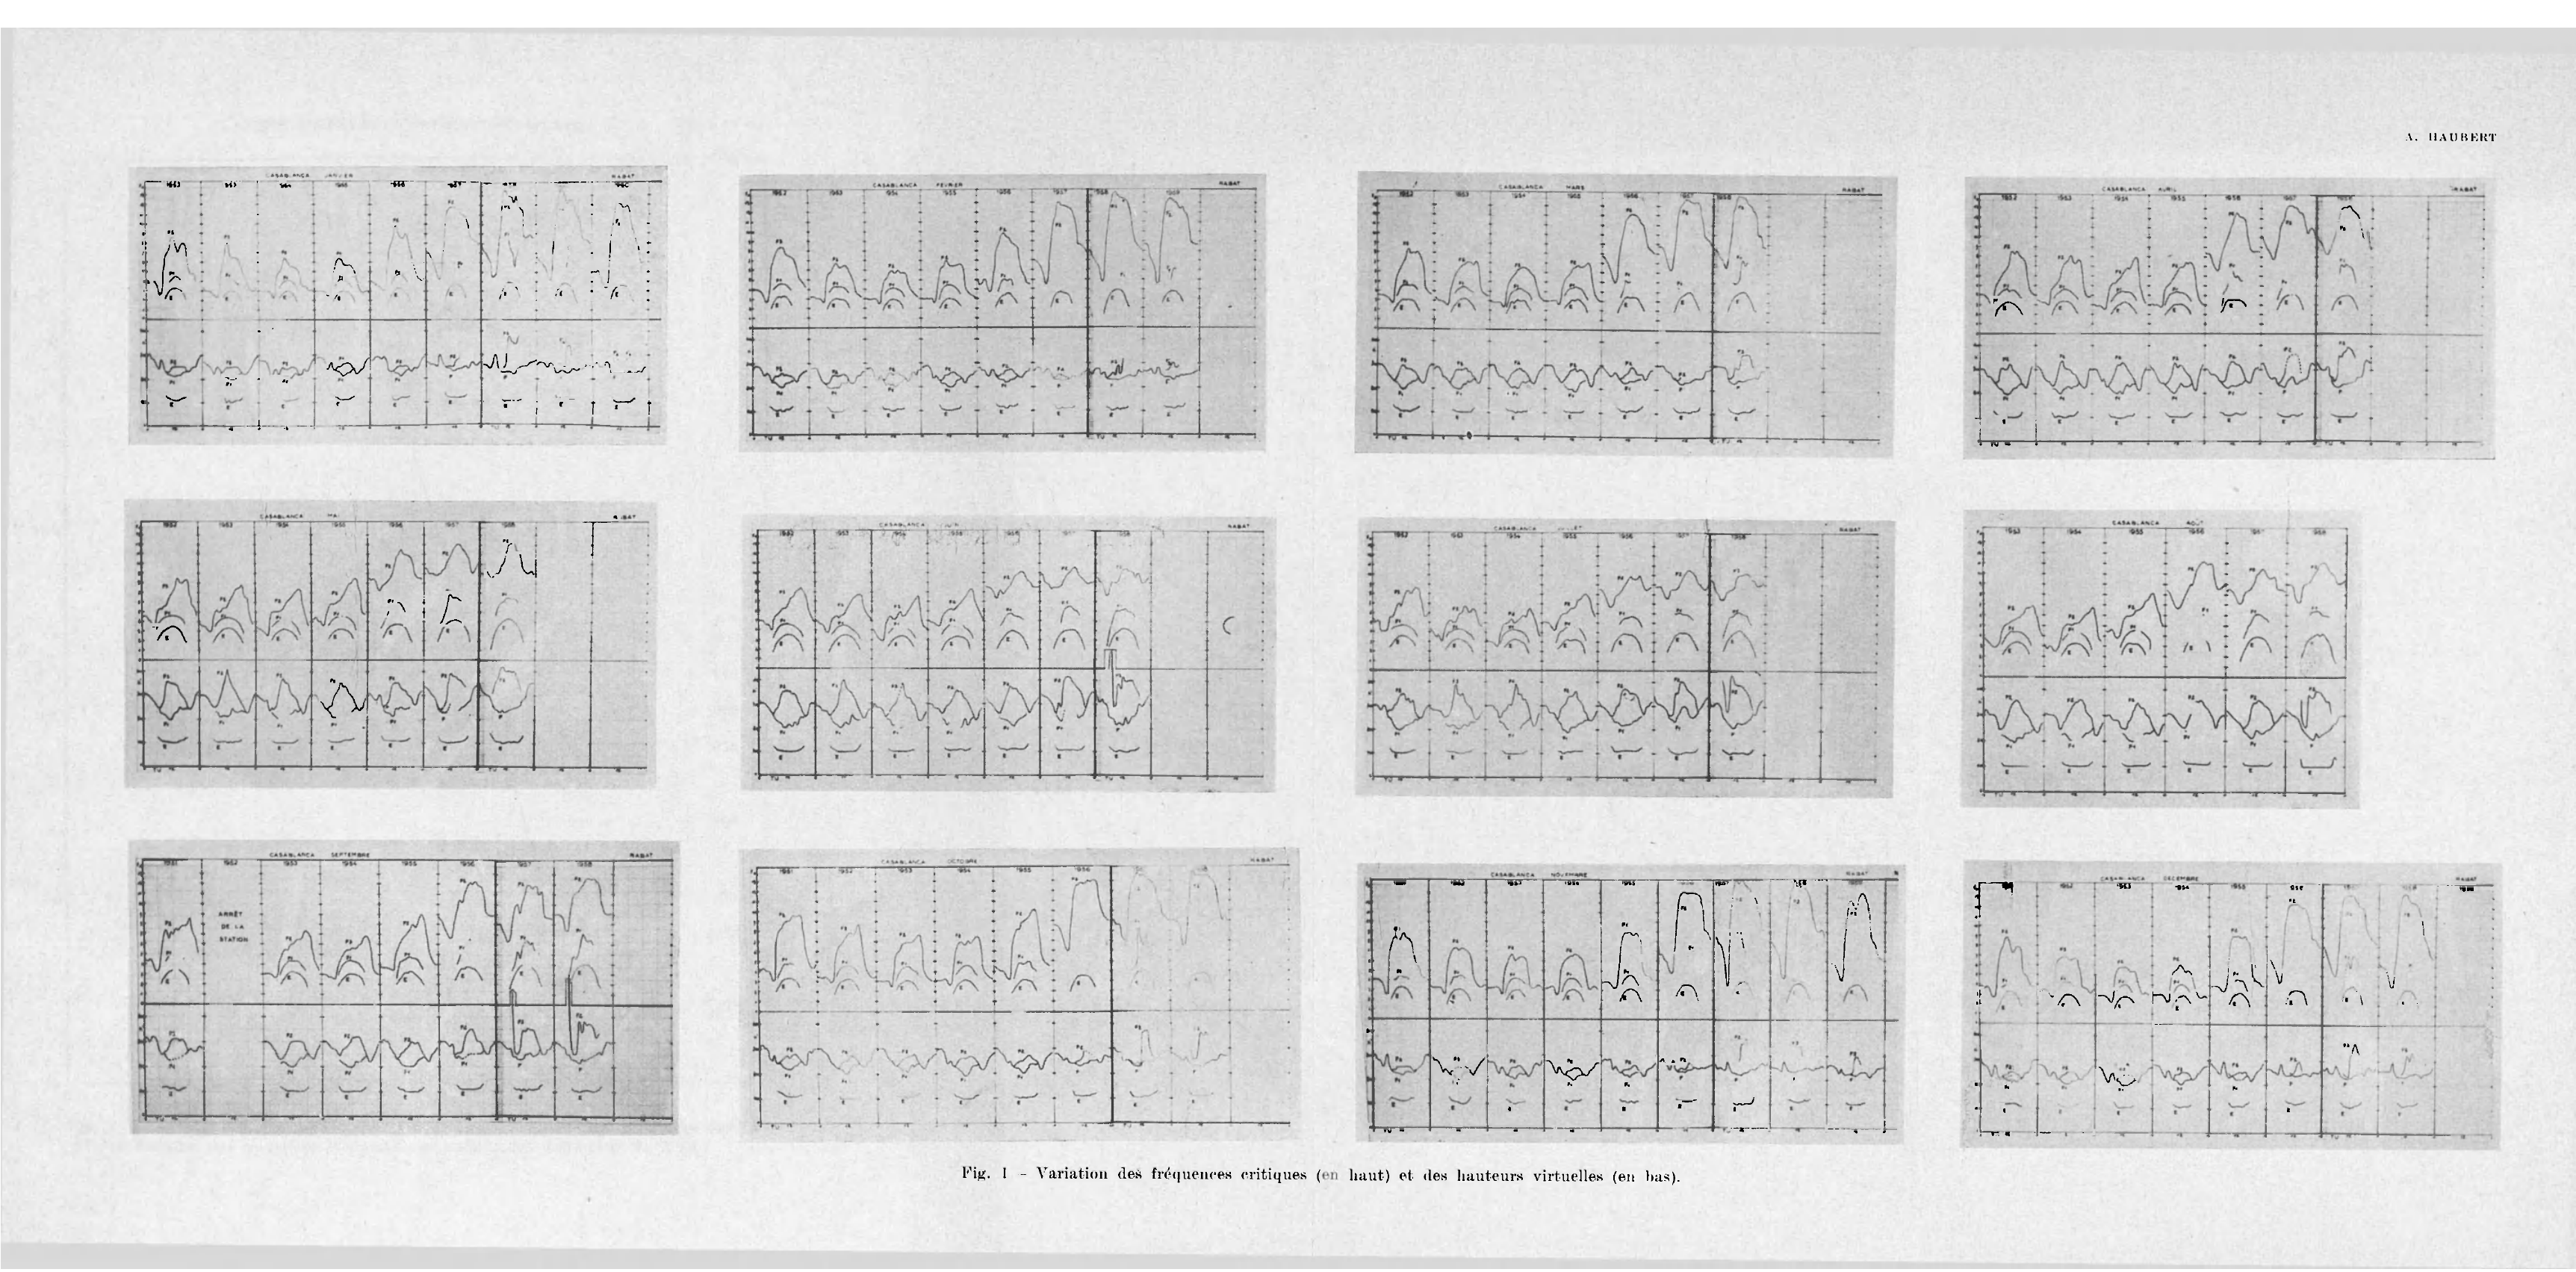
Fig. 1 - Variation des fréquences critiques